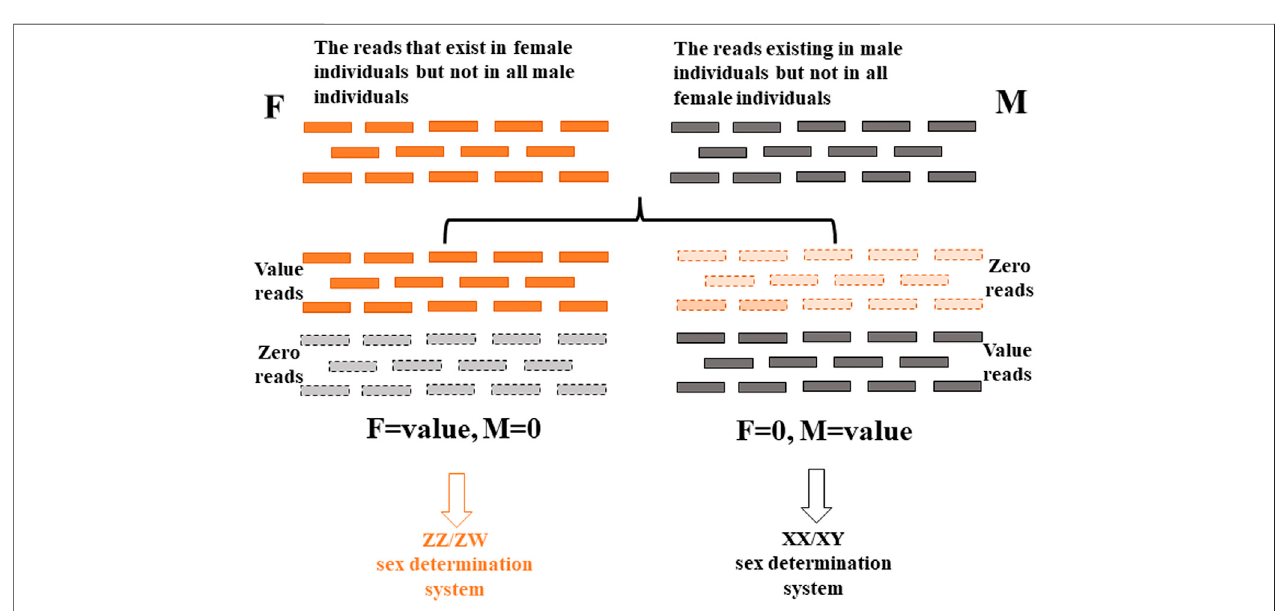
FIGURE 1 | Schematic diagram of the overall research framework for exploring the sex determination system based on next-generation sequencing data.